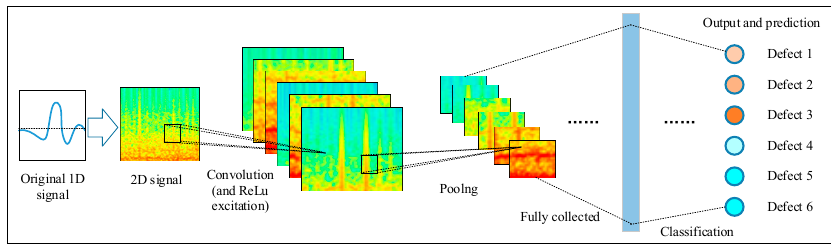
Figure 10. Framework of the 1D-CNNs.